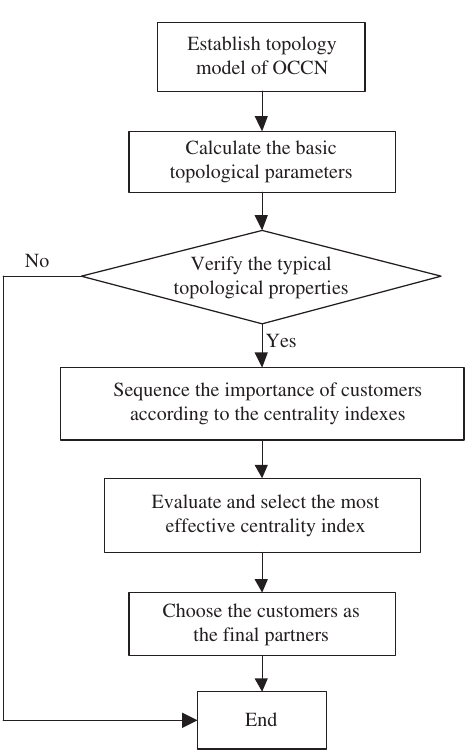
Figure 1. Flow Chart of Customer Partner